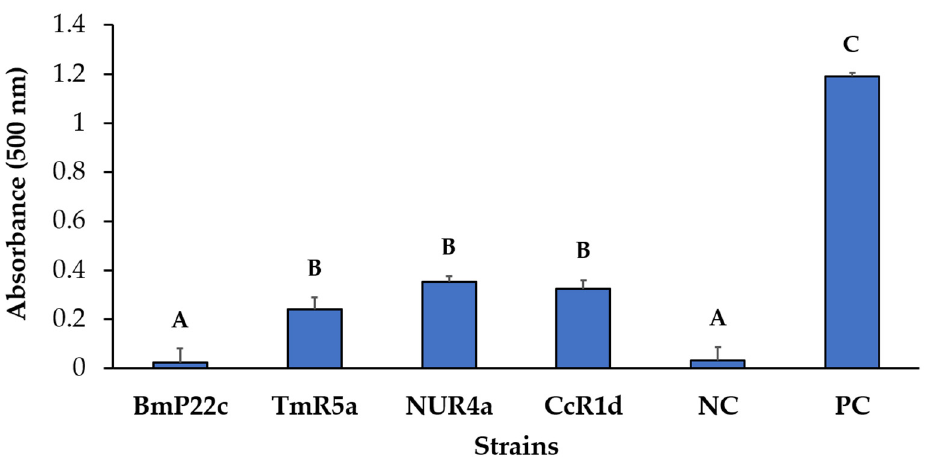
Figure 8. IRI activity of bacterial strains. The protein extracts were exposed to − 6 °C for 48 h to measure their absorbance at 500 nm. Each value is a mean ± SD of 6 independent replicates. Significant differences were analyzed by one-way ANOVA followed by the LSD Fisher test. Means with different letters indicate significant differences ( p < 0.05). Abbreviations: NC, negative control ( E. coli JM109); PC, positive control (Type III AFP); IRI, ice recrystallization inhibition.